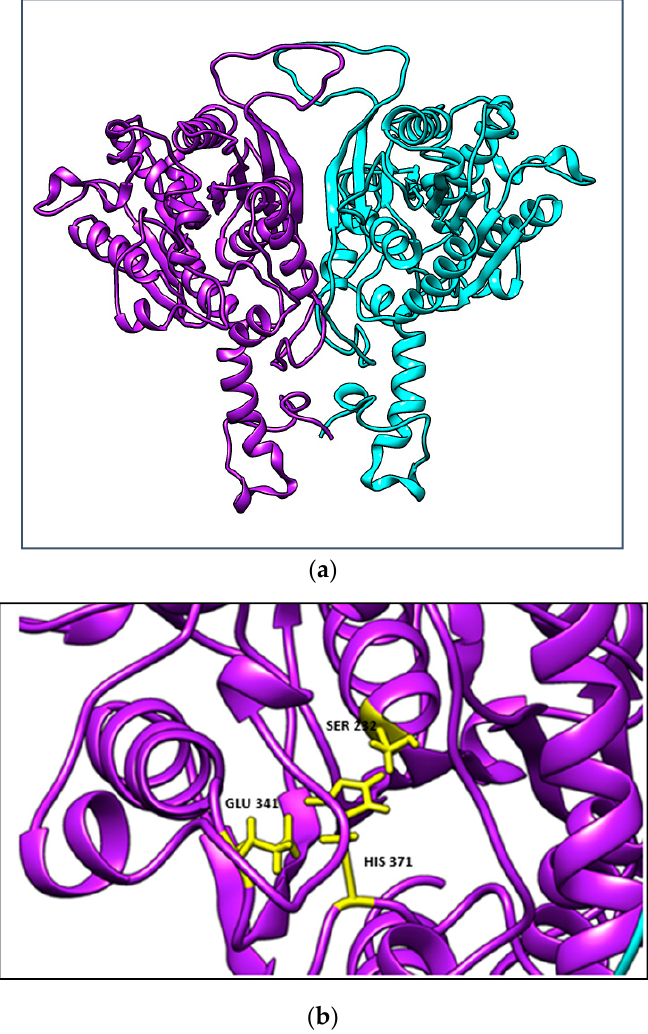
Figure 9. ( a ) The predicted GlaEst12 exists as dimer composed of two chain A (purple) and B (cyan) of α -helix structure, β -sheet, and coiled structures. ( b ) The catalytic triad of GlaEst12 was positioned at Ser 232 , Glu 341 , and His 371 and depicted in yellow.